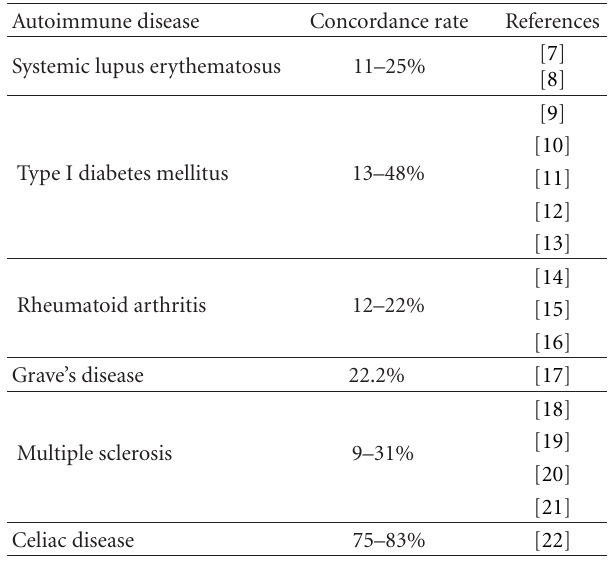
Table 1: Concordance rate of autoimmune diseases between mo- nozygotic